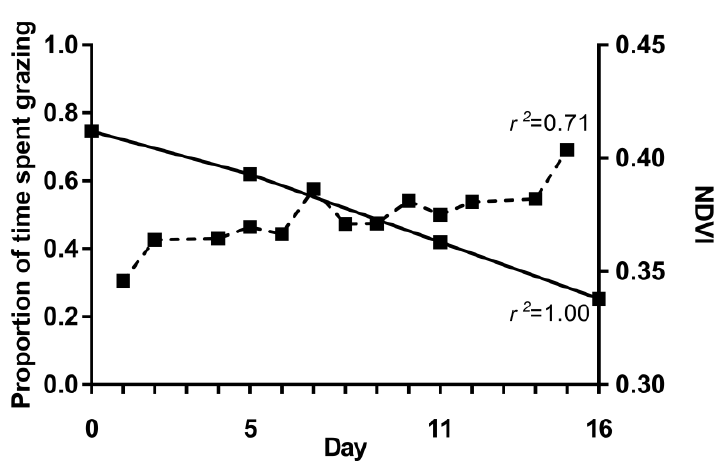
Figure 5. Proportion of observations (predicted value) in which cattle were recorded grazing per day (dashed line) and NDVI (Normalised Difference Vegetation Index; solid line) over the duration of the study.